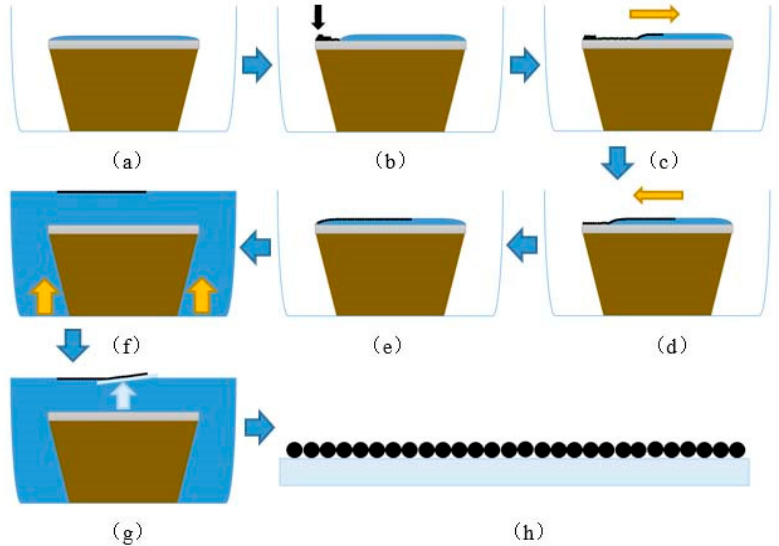
Figure 2. The fabrication process of interface self-assembly and transferred method. ( a ) water film on the substrate; ( b ) the mixed CS solution is first injected into water film; ( c – e ) a CS film formed at the air/water interface; ( f ) detach CS onto the water; ( g ) catching up the CS film by the substrate; ( h ) the CS film on the substrate.